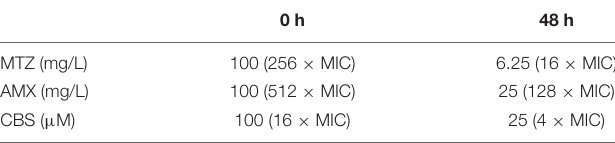
TABLE 1 | Antimicrobial concentrations of MTZ, AMX, and CBS after 48-h treatment of P. gingivalis.